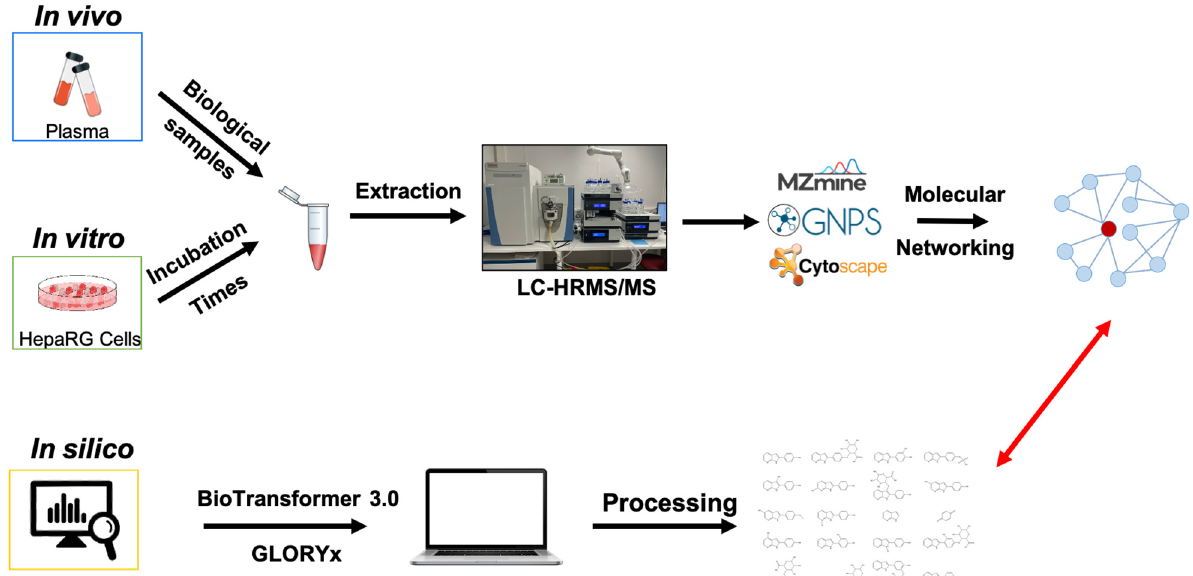
Figure 1. Overview methodology for cross-sectional study of sibiriline metabolism used in this study. LC-HRMS/MS = Liquid Chromatography coupled to a High-Resolution Tandem Mass Spec- trometer.